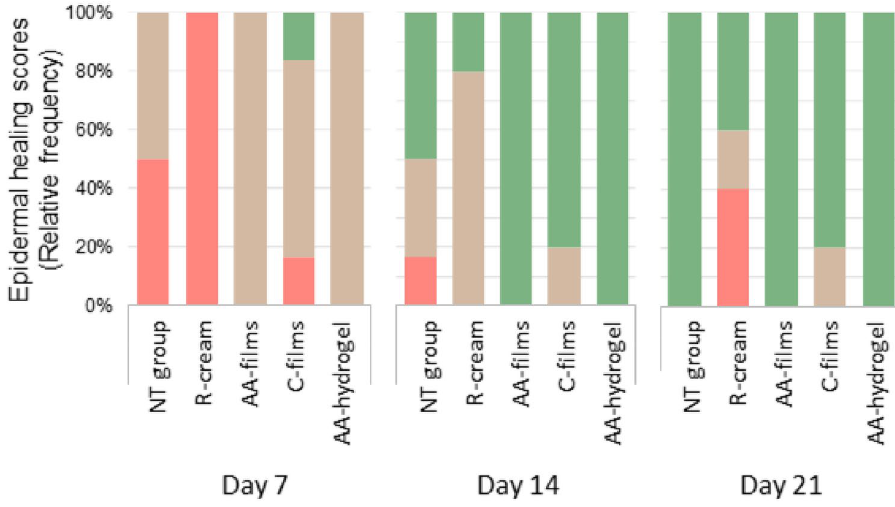
Figure 6. Epidermis scores were recorded as relative frequency of cases/week as: ( 1) Absent, ( 2) discontinuous and ( 3) continuous.